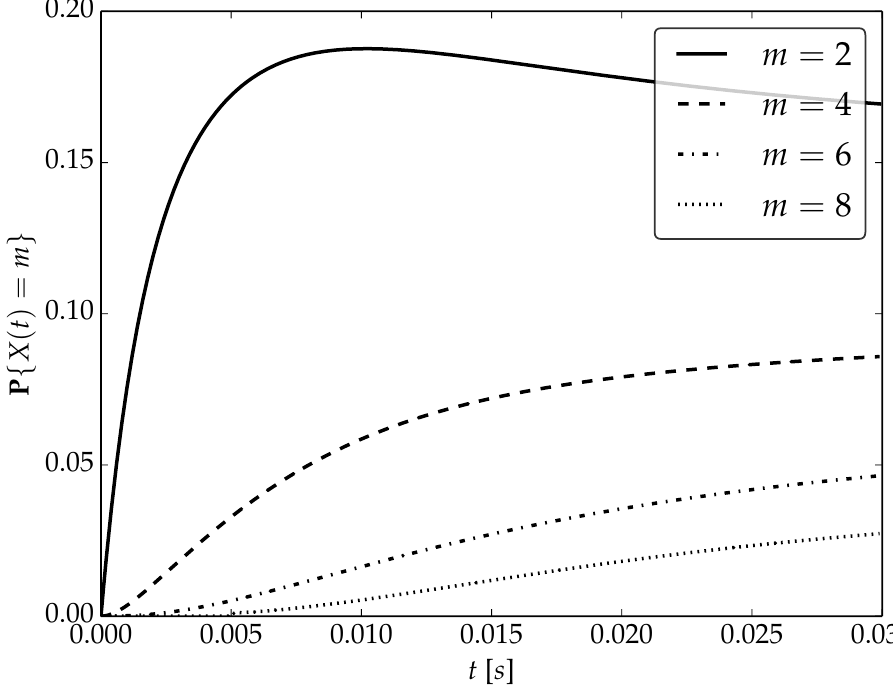
Figure 1. Transient distributions P { X ( t ) = m } for N = 2, batch distribution P 1 and ρ =